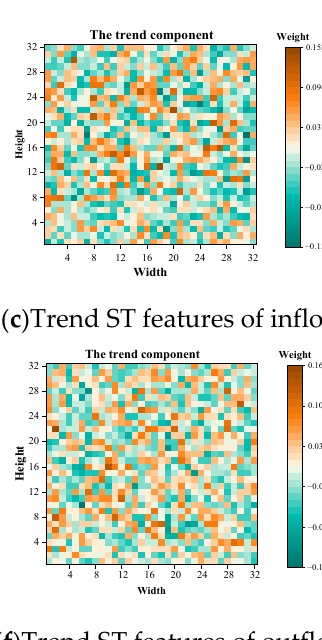
( f )Trend ST features of outflow